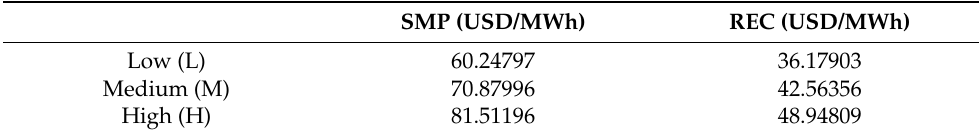
Table 4. SMP and REC prices.